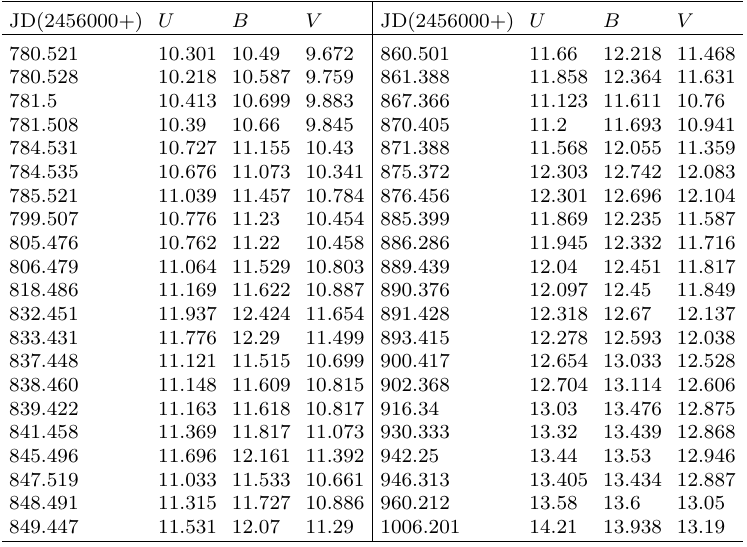
Table 3. UBV photometry of V2659